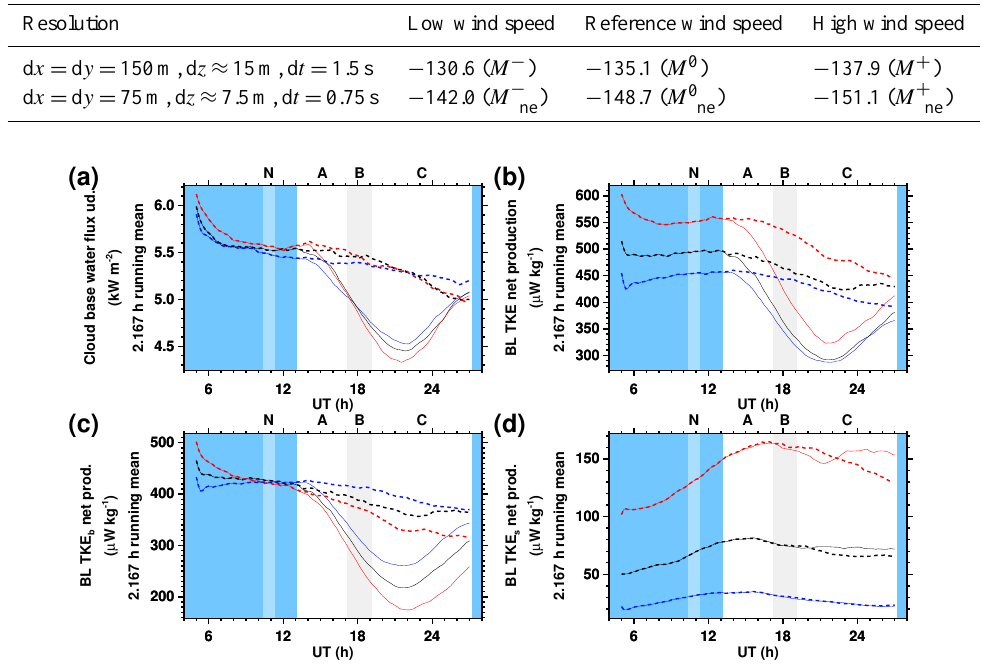
Table 3. Total (shortwave + longwave) top-of-atmosphere cloud radiative effect (Wm − 2 ) averaged over the 24h duration of the simulations. Simulations are given in parentheses (Table 2).